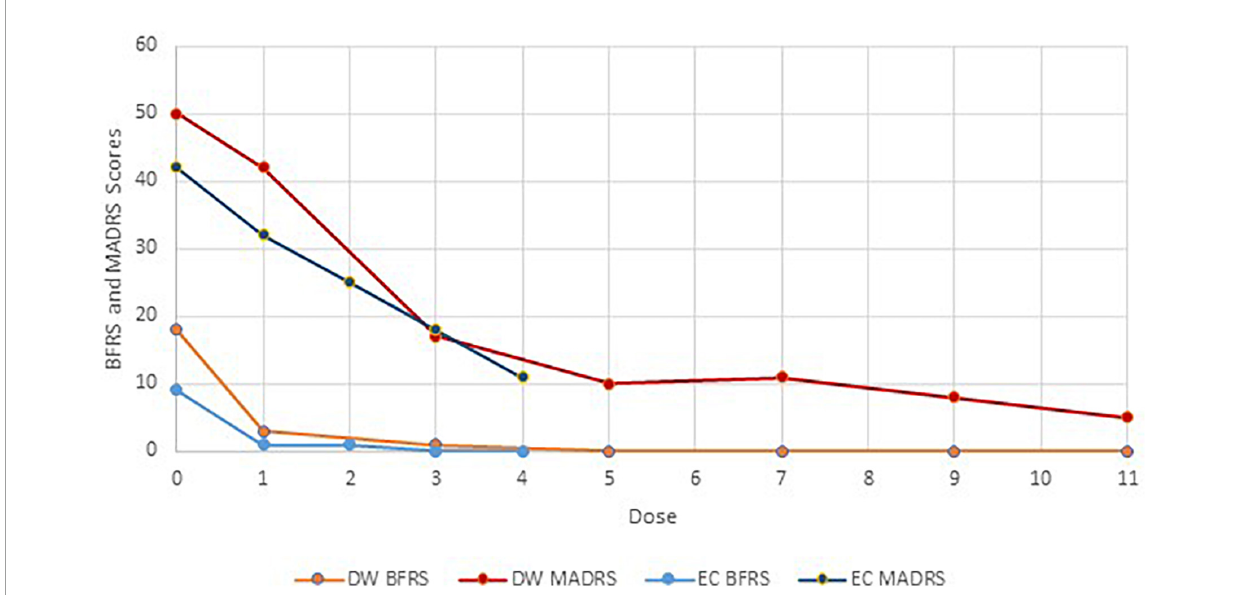
FIGURE1 Montgomery-Åsberg Depression Rating Scale and BFRS scores and IV ketamine treatment